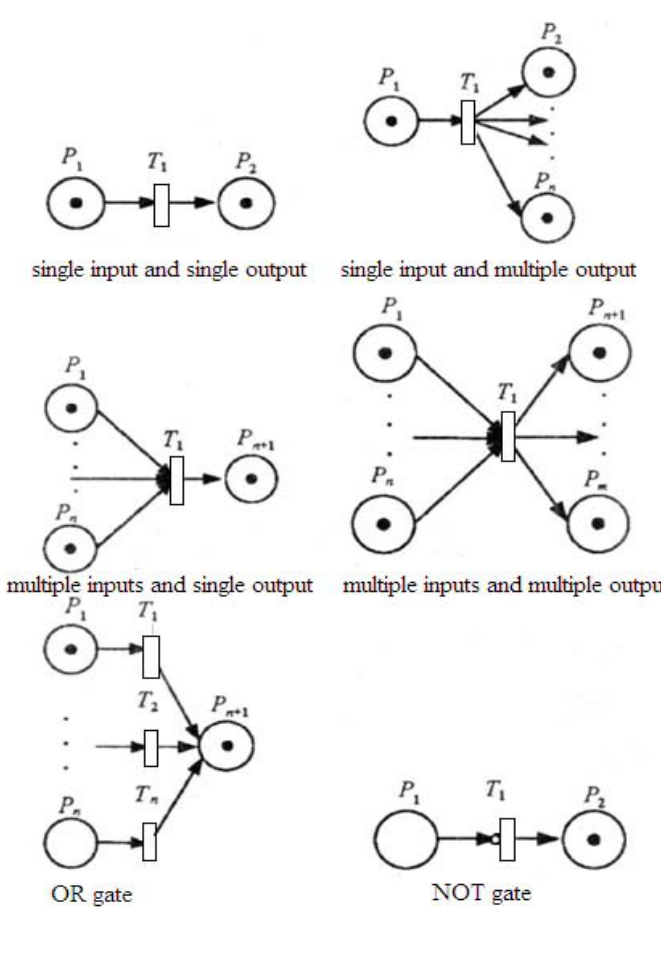
Figure 12. Minimal unit model of a fault Petri